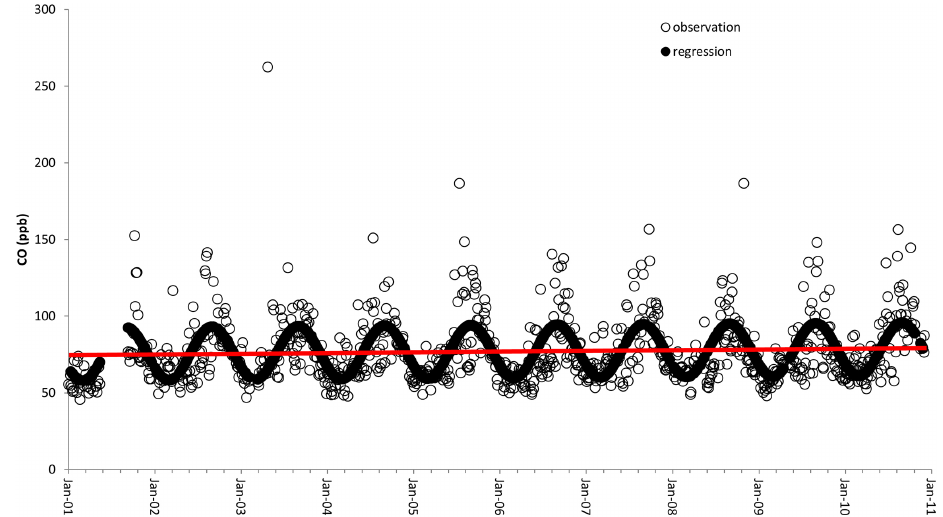
Figure 6. Time evolution of CO concentrations (ppb) in 2001–2010 at Ascension Island. A trend line is shown in